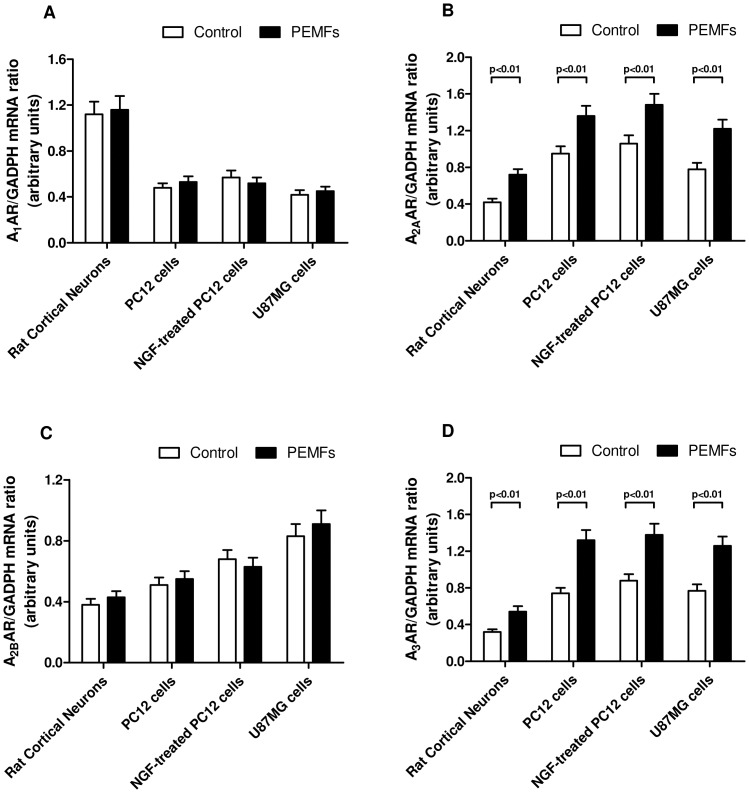
PEMFs increased A2A and A3AR mRNA levels.Relative mRNA expression of A1, A2A, A2B and A3ARs in rat cortical neurons, untreated or NGF-treated PC12 cells and U87MG cells in the absence or in the presence of PEMFs. Values are the mean (n = 6) ± SEM.